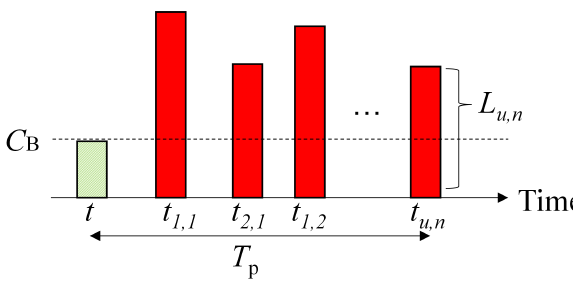
Figure 7. Illustration of traffic generation.